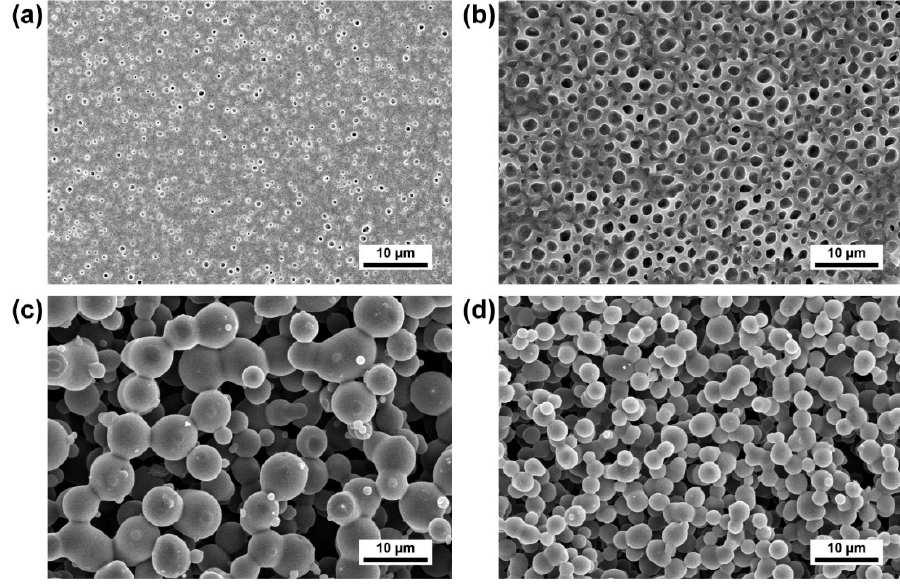
Figure 3. The polymer morphologies of samples A1–A4: ( a ) Sample A1; ( b ) Sample A2; ( c ) Sample A3; ( d ) Sample A4.